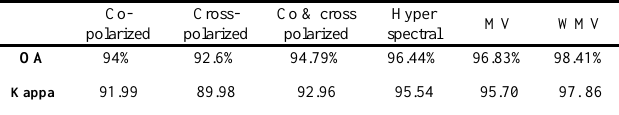
Table 4 : Overall Accuracy (OA) and Kappa coefficient